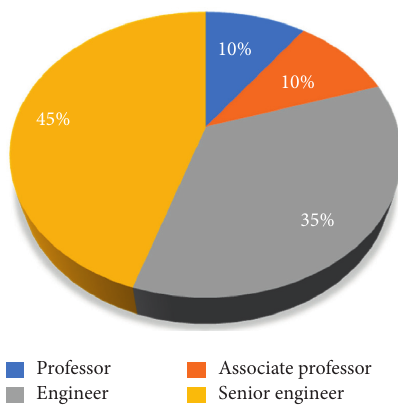
Figure 2: Distribution of expert